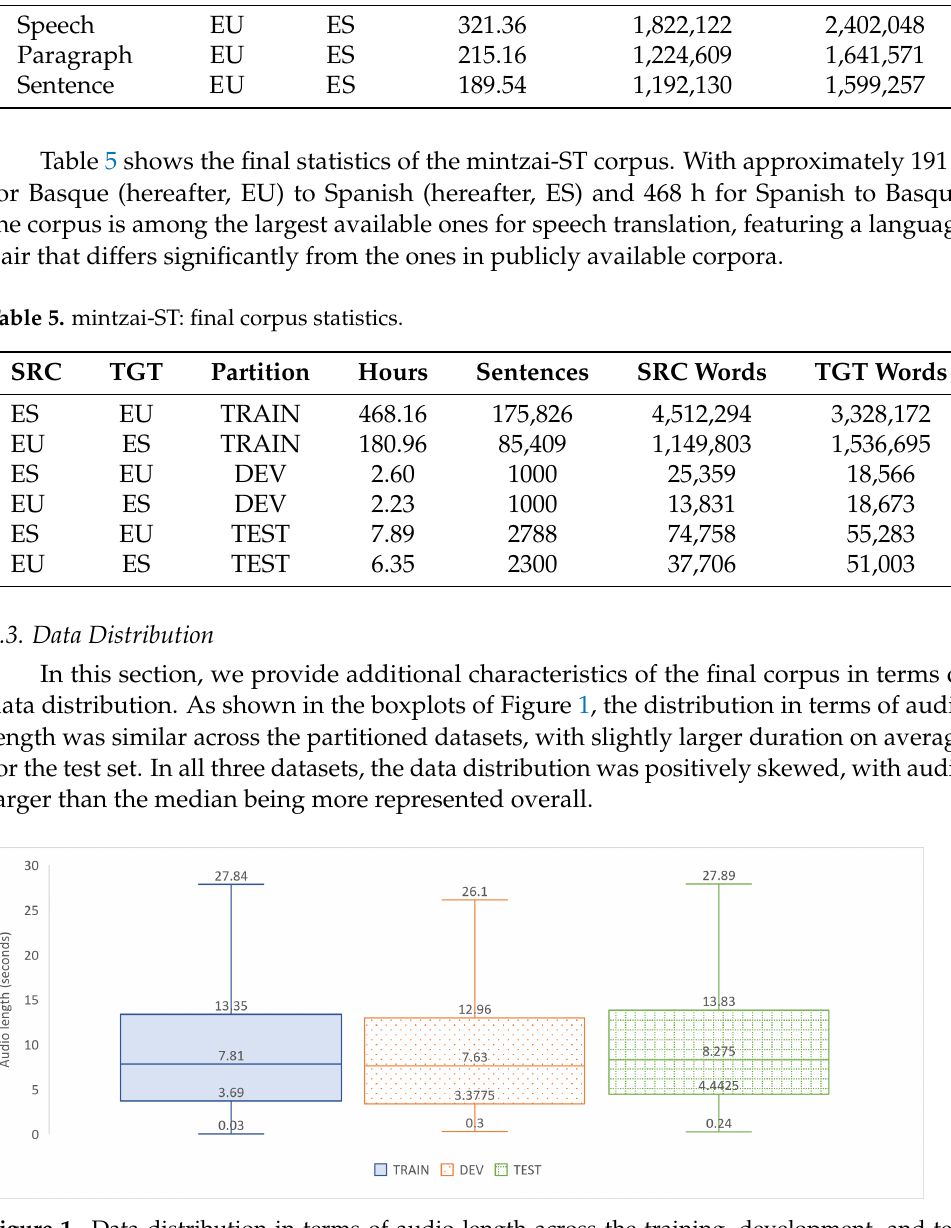
Figure 1. Data distribution in terms of audio length across the training, development, and test partitions for the Basque and Spanish data in the mintzai-ST